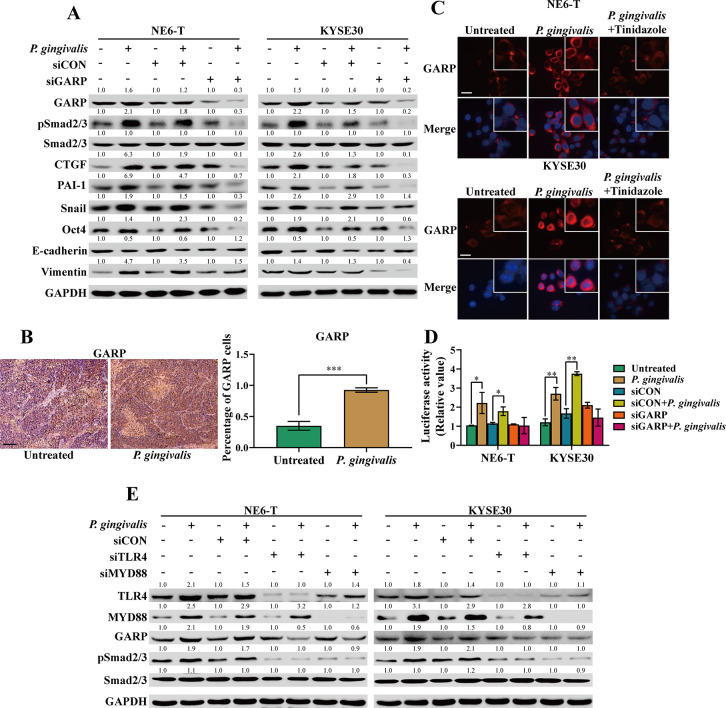
P. gingivalis-induced GARP up-regulation promotes TGFβ bioactivity and drives aggressiveness of ESCC.(A) Western blots were used to detect the indicated protein levels in ESCC cells with different treatments. Representative of 3 independent experiments. (B) Representative immunostaining of GARP proteins in xenograft tumor tissues from NE6-T. Scale bar, 200 μm. (C) Subcellular localization of GARP was detected by immunofluorescence microscopy in NE6-T and KYSE30 cells treated with PBS control or P. gingivalis. Scale bar represents 50 μm. **P < 0.01 by Student t test. (D) NE6-T and KYSE30 cells were transfected with control siRNA or siRNA targeting GARP and treated with P. gingivalis for 24 h and dual luciferase assay of Smad reporter was performed. R. luciferase activity was normalized to firefly activity as relative luciferase activity. *P < 0.05, **P < 0.01 by Student t test. n = 3 independent experiments performed in triplicate. (E) NE6-T and KYSE30 cells were transfected with control siRNA or siRNA targeting TLR4 or MYD88 and then treated with P. gingivalis. Western blots were used to detect the indicated protein levels in NE6-T and KYSE30 cells with different treatments. Representative of 3 independent experiments. CTGF, connective tissue growth factor; ESCC, esophageal squamous cell carcinoma; GAPDH, glyceraldehyde-3-phosphate dehydrogenase; GARP, glycoprotein A repetitions predominant; MYD88, myeloid differentiation primary response protein 88; PAI-1, plasminogen activator inhibitor-1; PBS, phosphate-buffered saline; pSmad, phosphorylated Smad; siCON, scramble control for short interfering RNA; siRNA, short interfering RNA; Smad, Drosophila mothers against decapentaplegic homolog; TGFβ, transforming growth factor-β; TLR4, toll-like receptor 4.